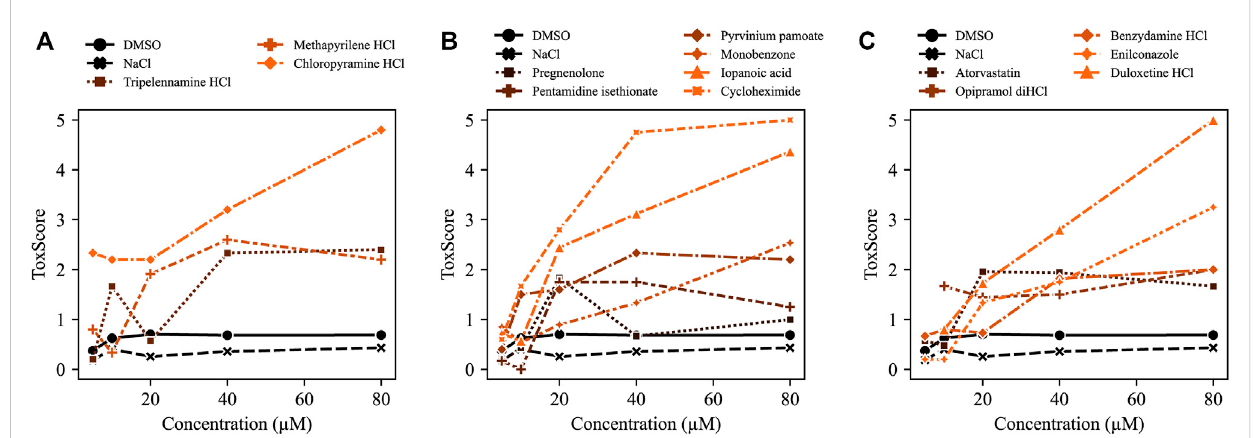
FIGURE 6 ToxScores of increasing compound concentrations. The compounds concentration-dependently increased ToxScores in treated zebra fi sh embryos.TheToxScoresof (A) threeHRH1antagonists, (B) variouscompounds,and (C) hydrochlorides(HCls).Thecolorgradientindicatestheseverityof the ToxScore from black (low ToxScore) to orange (high